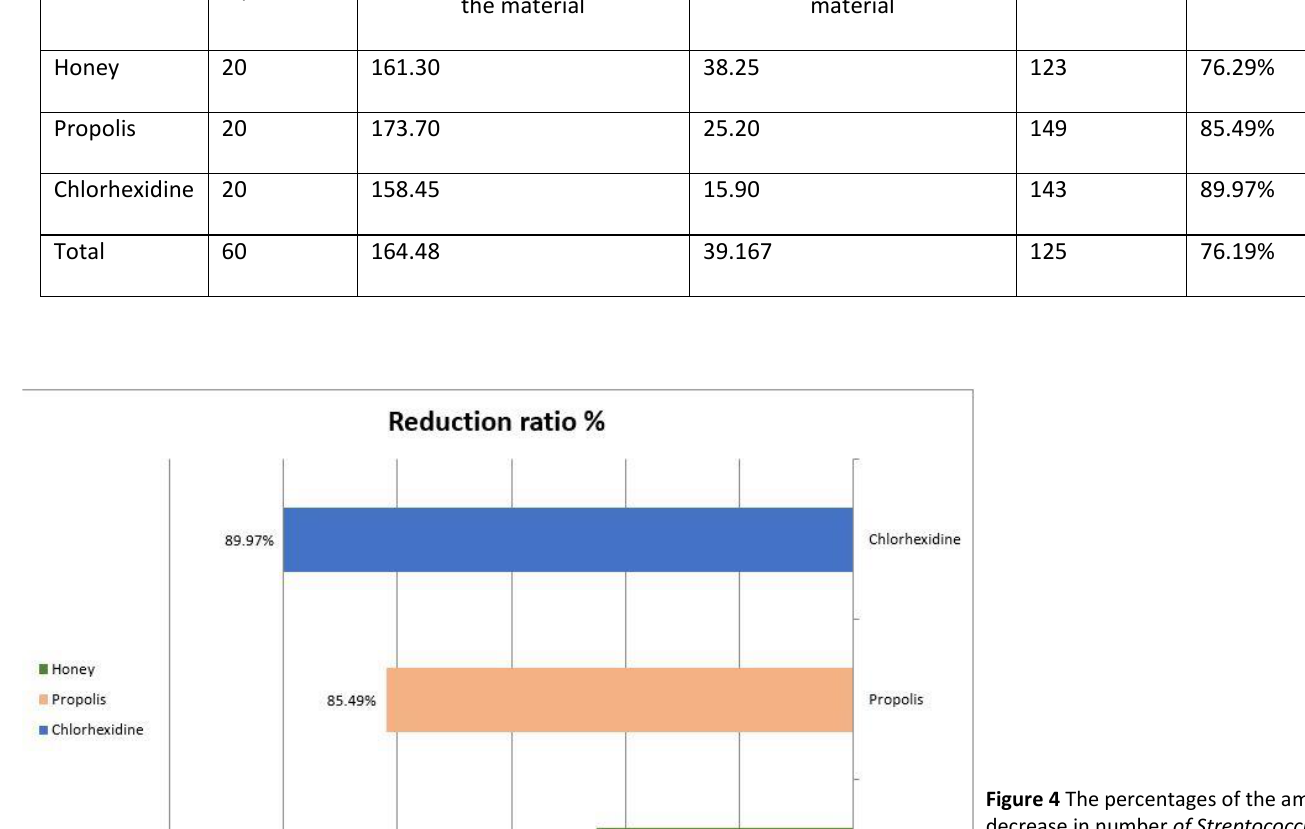
Figure 4 The percentages of the amount of decrease in number of Streptococcus mutans between the two times (before using the substance and after using the substance) between the three experimental